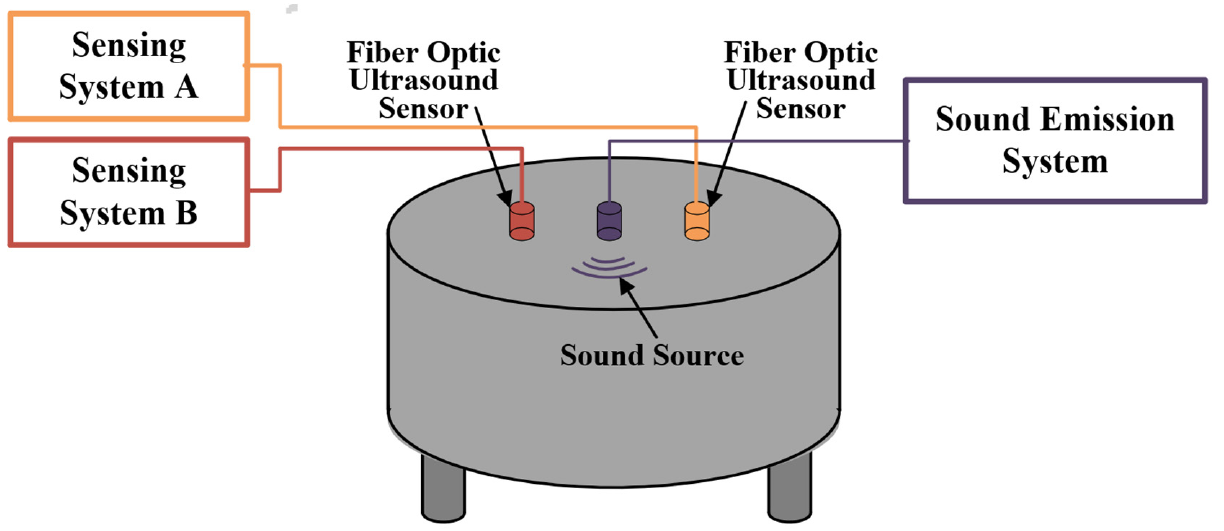
Figure 8. Ultrasonic calibration platform.